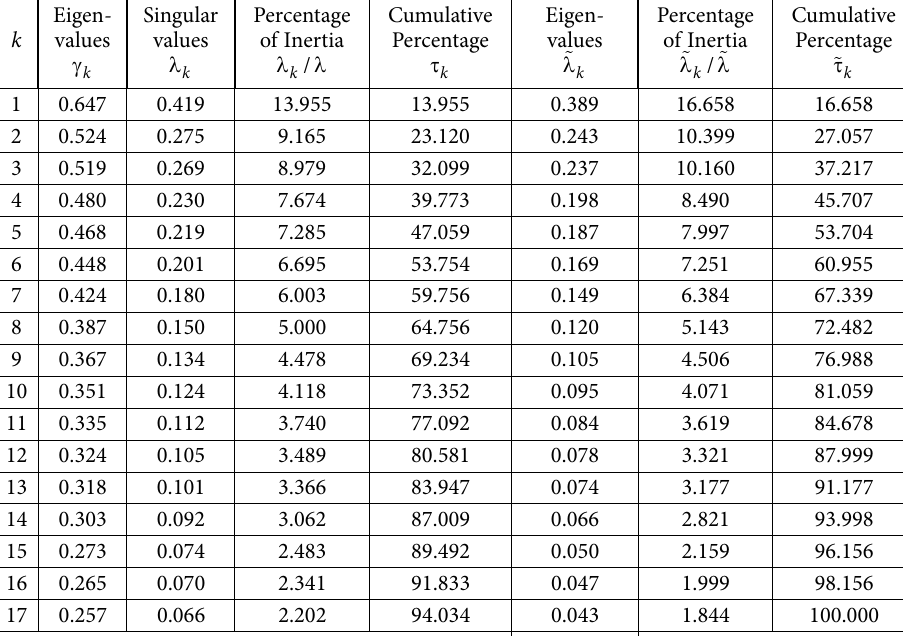
Table 5. The results of original and modified versions of correspondence